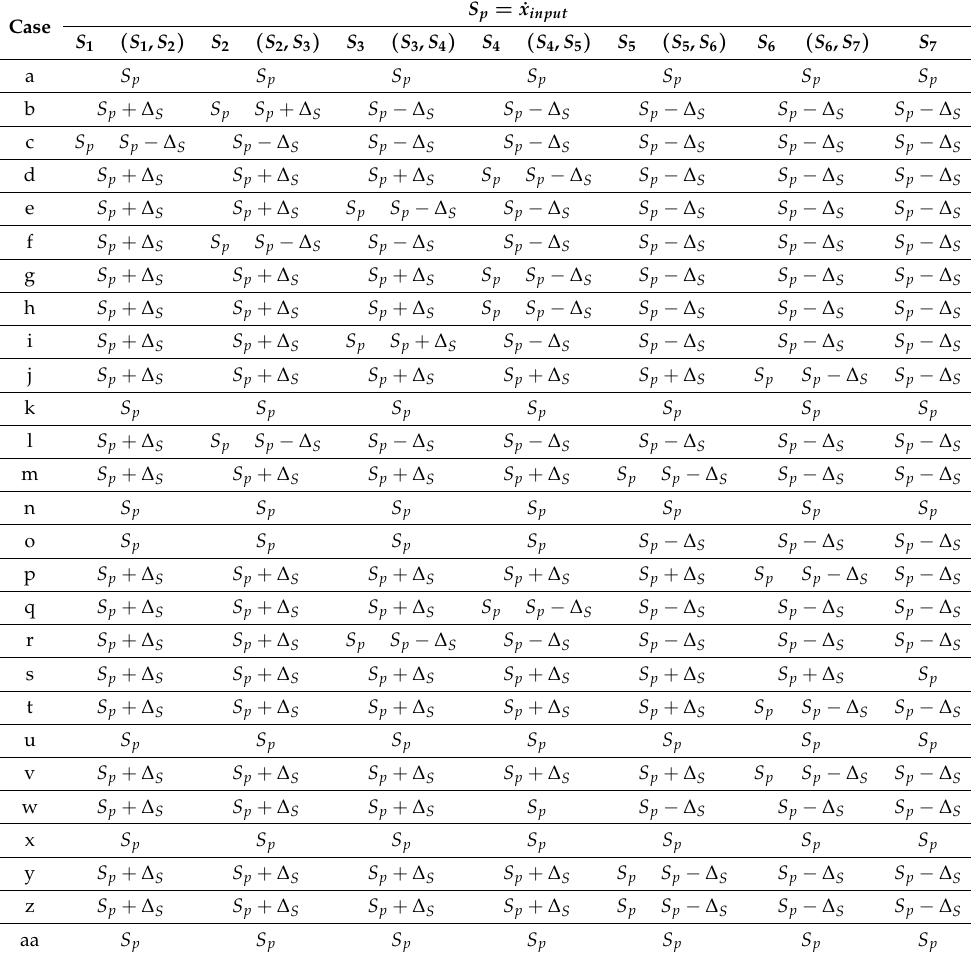
Table A1. Velocity regulation according to the input combination from Table 2 and the previous velocity value ( ˙ x ref ( n − 1 ) ). The final decision could be to maintain speed ( S p ), increase speed ( S p + ∆ S ), or decrease speed ( S p − ∆ S